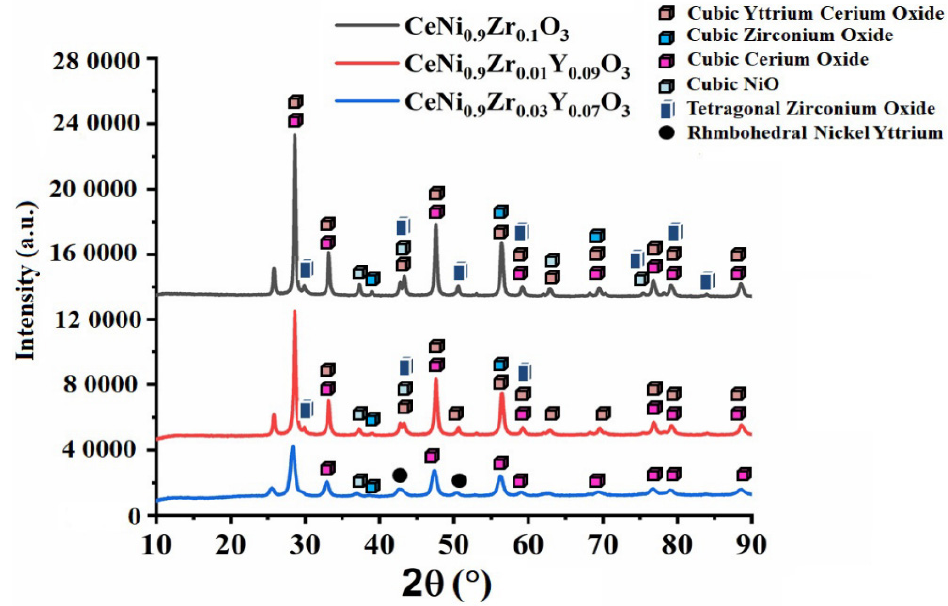
Figure 3. XRD pattern of perovskite catalyst CeNi 0.9 Zr 0.1 − x Y x O 3 ( x = 0.00, 0.07 and 0.09).